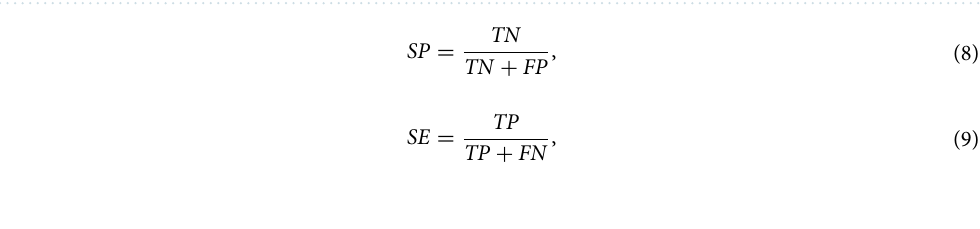
Figure 4. ( a ) A fundus image, boundary pixels for red-lesions for ( b ) d 0 = 10, ( c ) d 0 = 16, ( d ) d 0 = 22, ( e ) all boundary pixels for